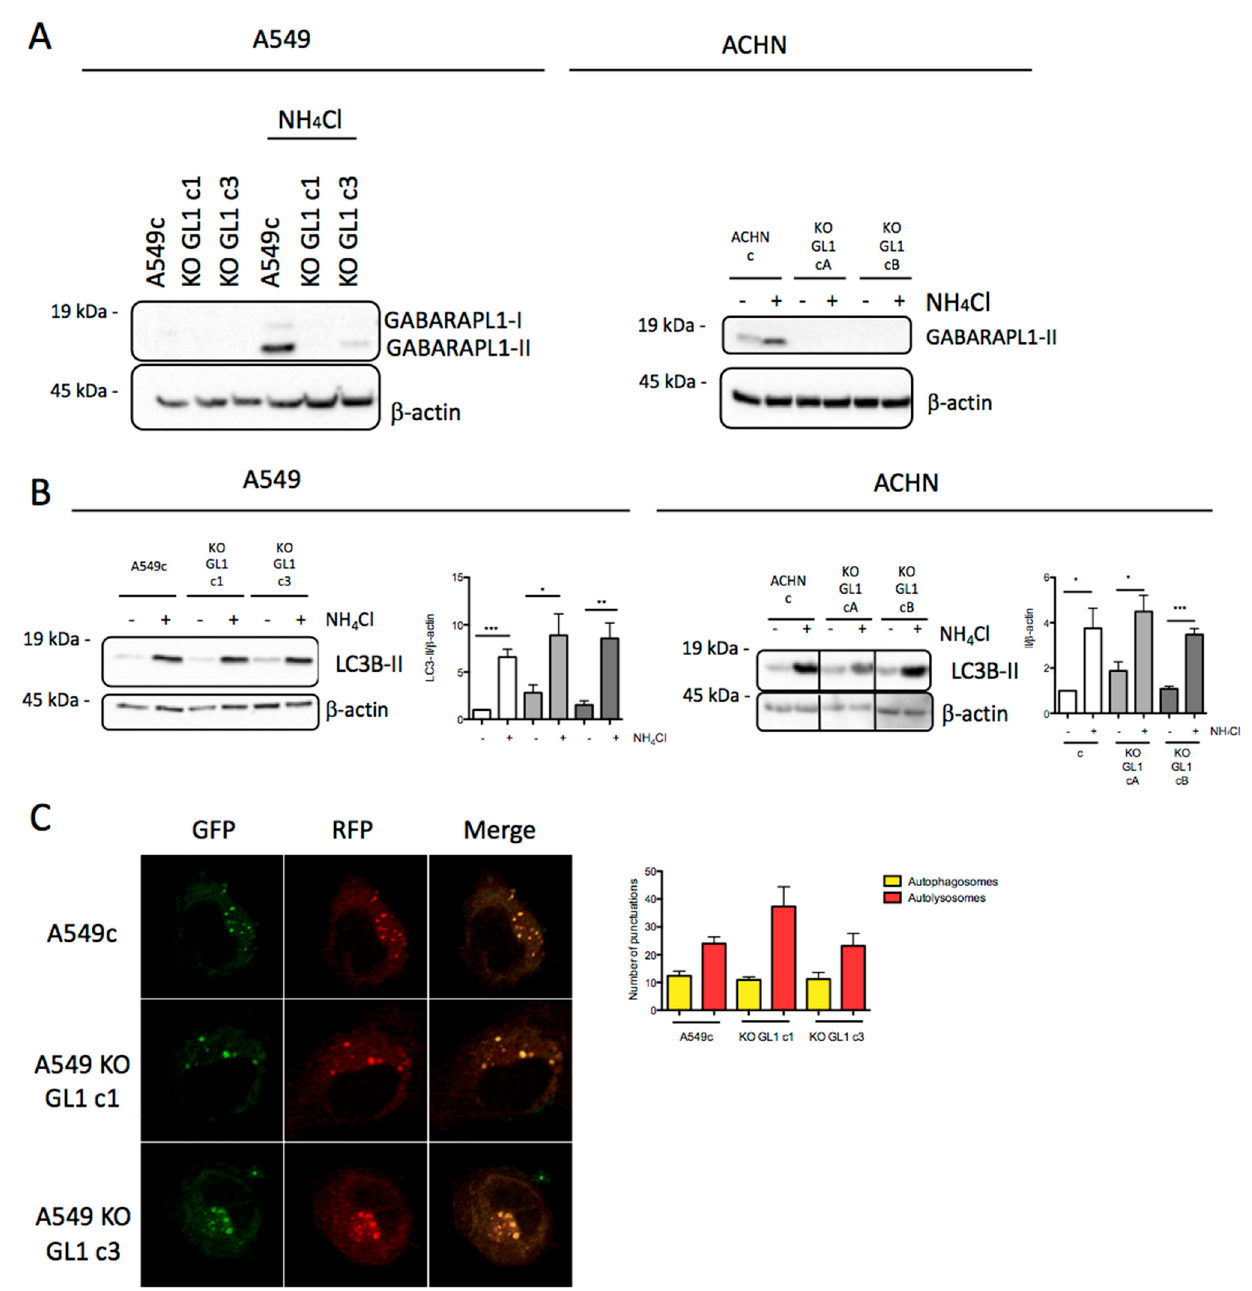
Figure 3. The GABARAPL1 knockout does not modify autophagic flux. ( A ) Western blot analysis of GABARAPL1 levels in A549c, ACHNc, and KO GABARAPL1 cells untreated or treated with 50 mM NH 4 Cl for 2 h. ( B ) Western blotting analysis of LC3B levels in A549c, ACHNc, and KO GABARAPL1 cells cultured in complete medium and treated, or not, with 50 mM NH 4 Cl for 2 h. β -actin was used as a loading control. Protein levels were quantified using Image Lab. ( C ) GFP-RFP-LC3 puncta analysis in A549c and A549 KO GL1 cells transfected with the ptf-LC3 vector and cultured in complete medium, by confocal microscopy. Each picture is representative of a typical staining observed in 20 fields chosen at random. Red and yellow puncta were counted using ImageJ software (green and red puncta colocalization tool). In each group, 20 cells were randomly selected. Scale bar: 5 m.